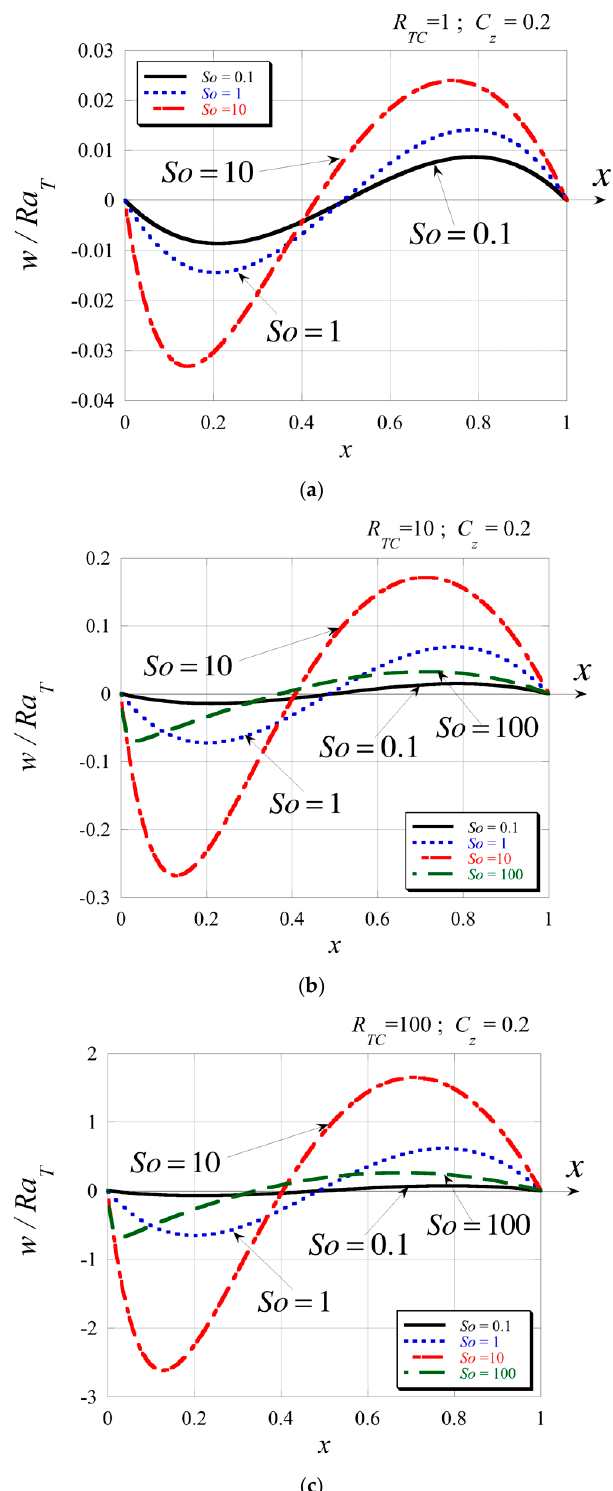
= 0.2 w Figure 6. Graphical profiles of the velocity solution for C Z and different Soret num- Figure 6. Graphical profiles of the velocity solution w for C Z = 0.2 and different Soret numbers: = 1 = 10 = 100 ( a ) R TC = 1, ( b ): R TC = 10, and ( c ) R TC = bers: ( a ) R TC , ( b ): R TC , and ( c ) R TC .